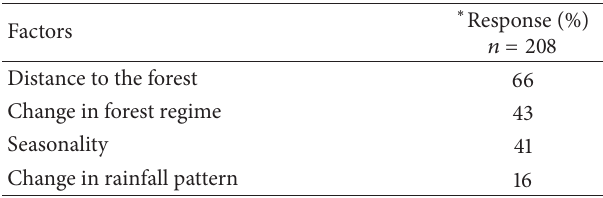
Table 6: Factors influencing supply of NTFPs at household level. Factors